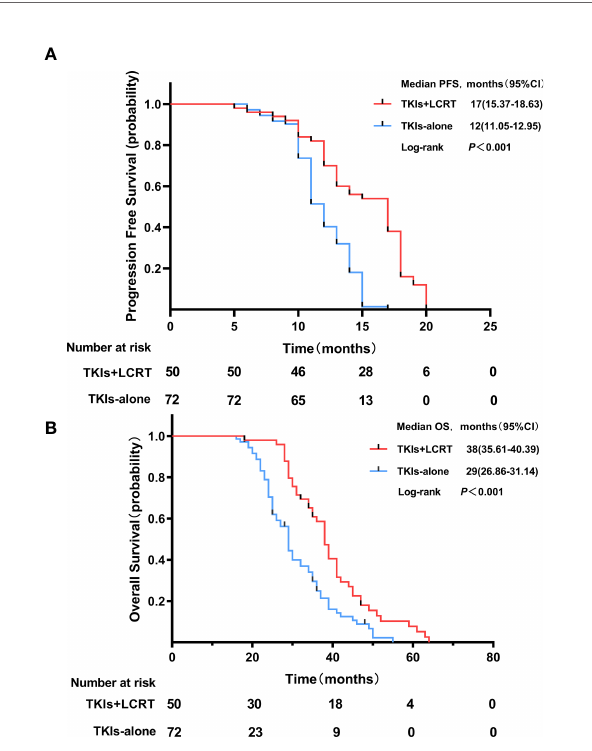
FIGURE 2 | Progression free survival (A) and overall survival (B) of patients treated with TKIs + LCRT or TKIs alone for oligometastatic NSCLC harboring EGFR activating